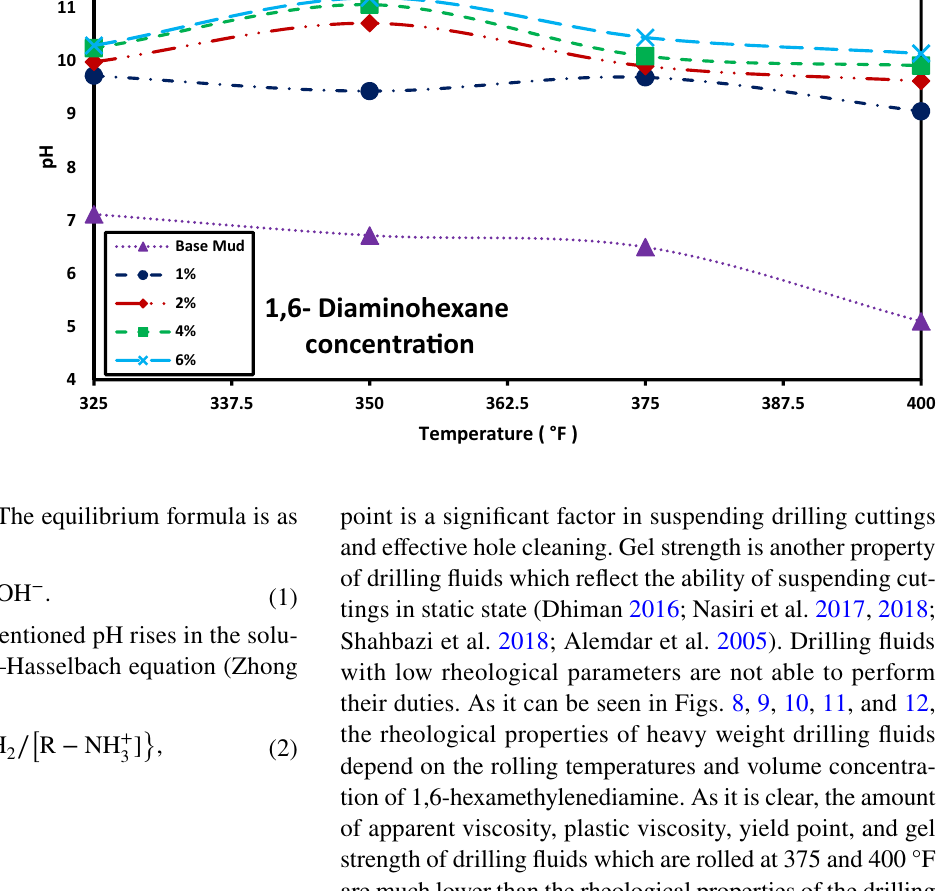
Fig. 7 Effect of the combination of 1,6-hexamethylenediamine and PAC on pH